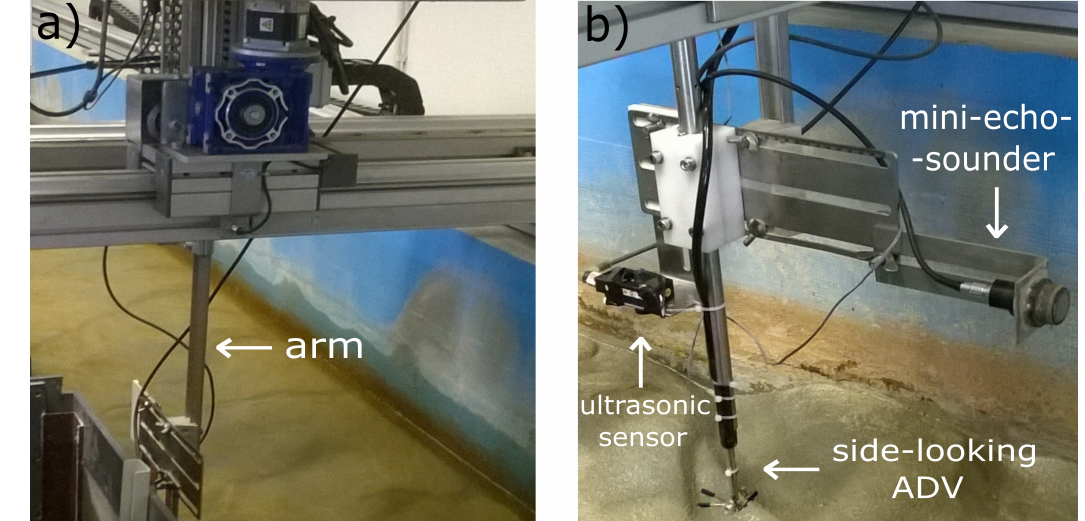
Figure 3. ( a ) robot. ( b ) mini-echo-sounder, ultrasonic sensor and side-looking Acoustic Doppler Velocimeter (ADV) (all probes out of